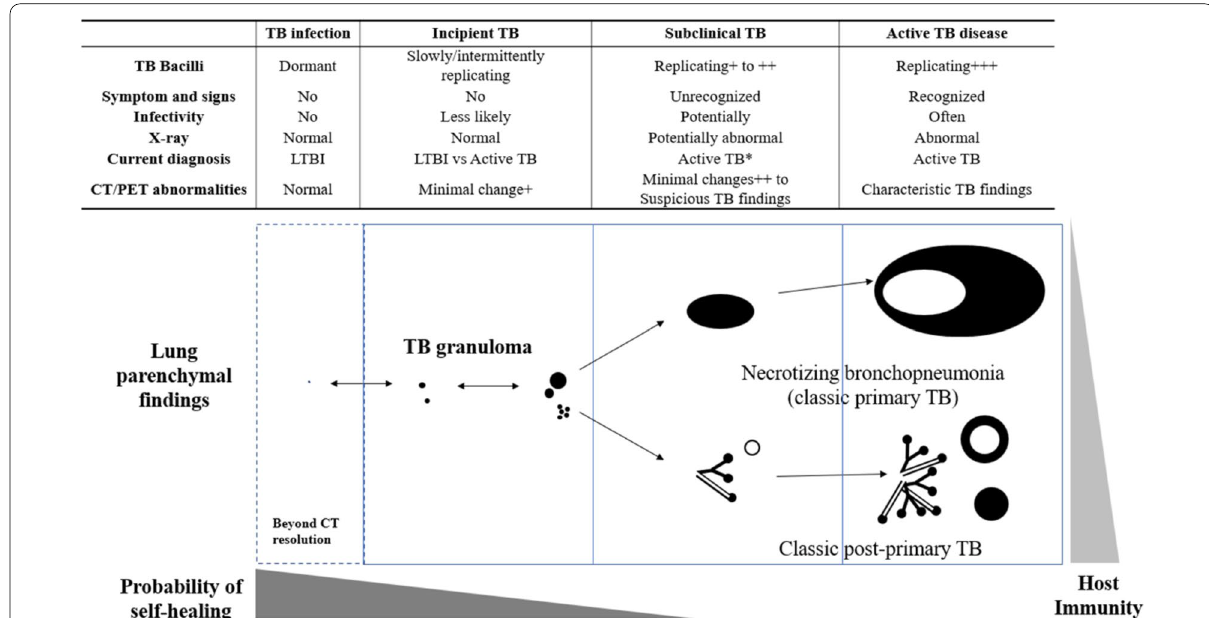
Fig. 4 Modern understanding of the tuberculosis disease spectrum, current diagnosis, and CT and. 18 F‑FDG PET abnormalities. *Close contacts to tuberculous patients with X‑ray abnormalities are regarded as patients with active